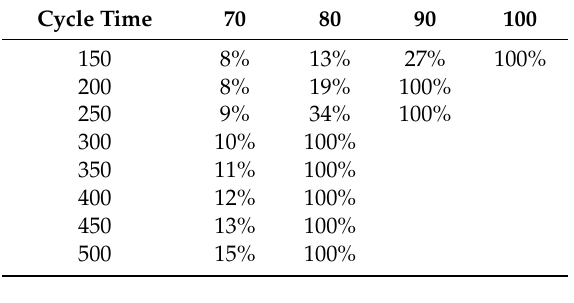
Figure 11. Reception rate by the message injection rate and message transmission cycle in AES-128. Table 10. Controller area network (CAN) message reception rate with format-preserving encryption (FPE)-FF1.